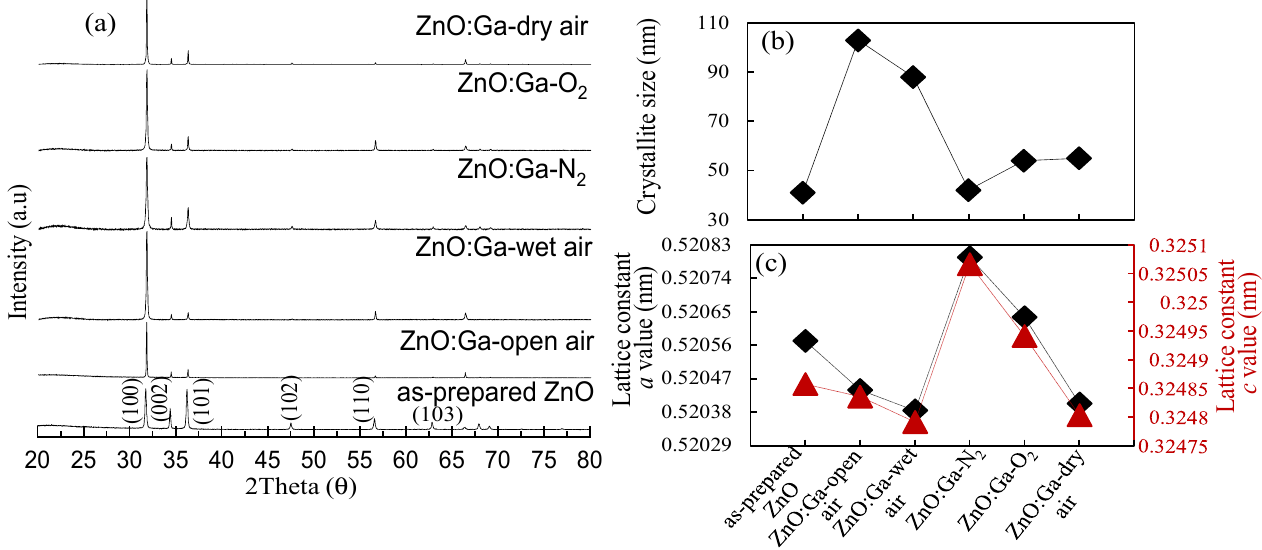
Figure 5. ( a ) X-ray diffraction patterns of spray coated NP layers, ( b ) the calculated crystallite size, and ( c ) lattice constant for a and c value.